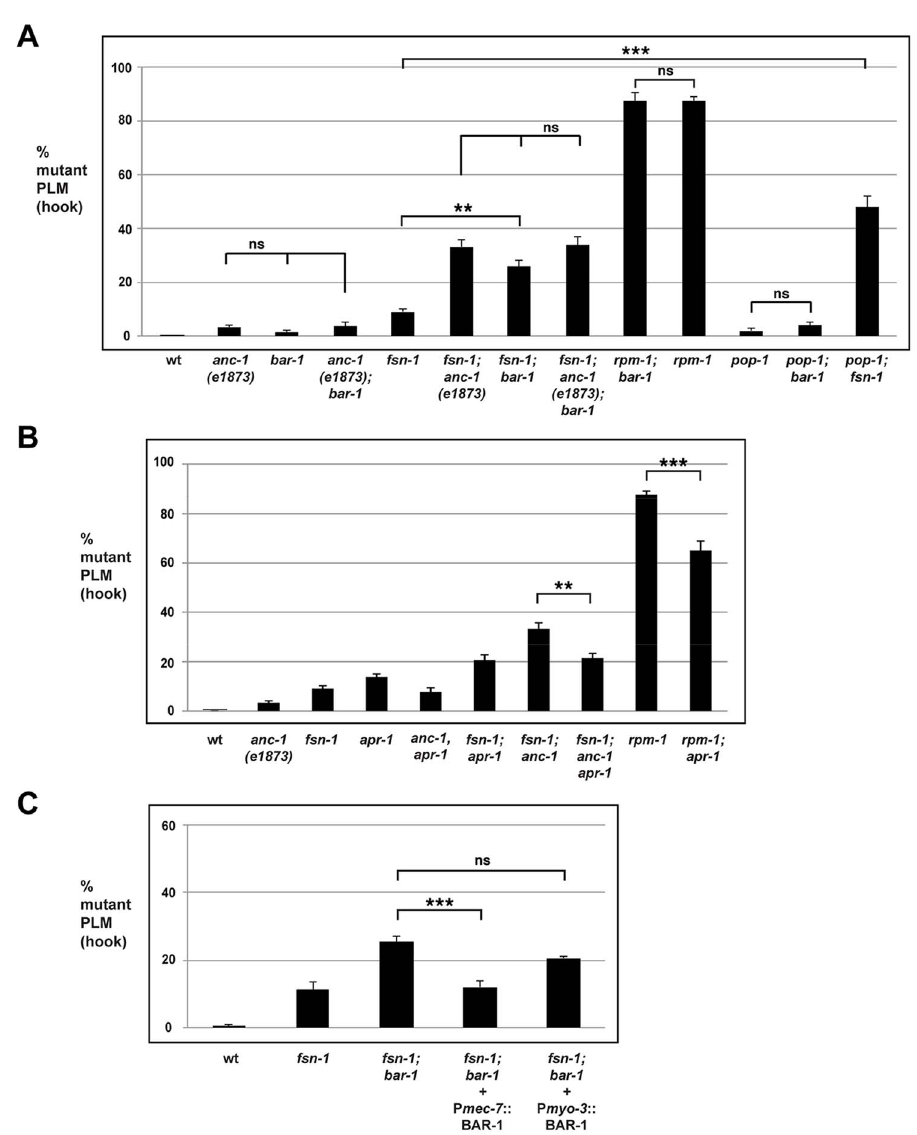
Figure 5. bar-1 functions downstream of anc-1 and rpm-1 to regulate axon termination. Quantitation of axon termination defects (hook) in PLM neurons for the indicated genotypes using muIs32 . (A) bar-1 and pop-1 analysis. (B) apr-1 analysis. (C) A cell specific promoter ( Pmec -7) was used to transgenically express BAR-1. Analysis was done on young adults grown at 23 u C. Significance was determined using an unpaired Student’s t test; error bars represent the standard error of the mean. ** P , 0.01, *** P , 0.001, ns=not significant.